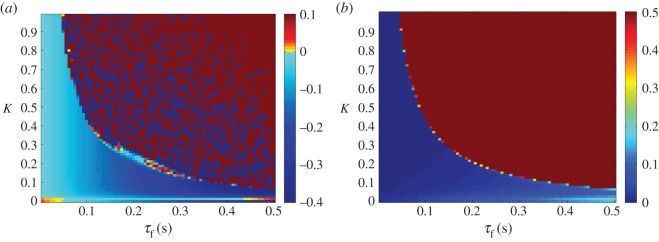
Lag (a) and lag-adjusted RMS error (b) between xtarget and xeffector, plotted as a heat map. τ is set to 0 s, while τf is varied between 0.01 and 0.5 s. Anticipation (seen here as blue, negative lag values) increases with τf, reaching its maximum near the stability boundary (which can be approximated by Kτf=0.14) beyond which error rises above acceptable levels and lag can no longer be accurately measured. For this reason, the error is saturated at 0.5.